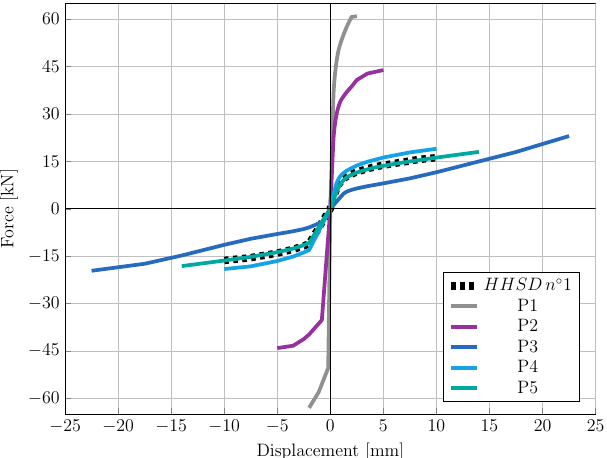
Figure 7. Comparison of the envelope curves of the studied geometries.